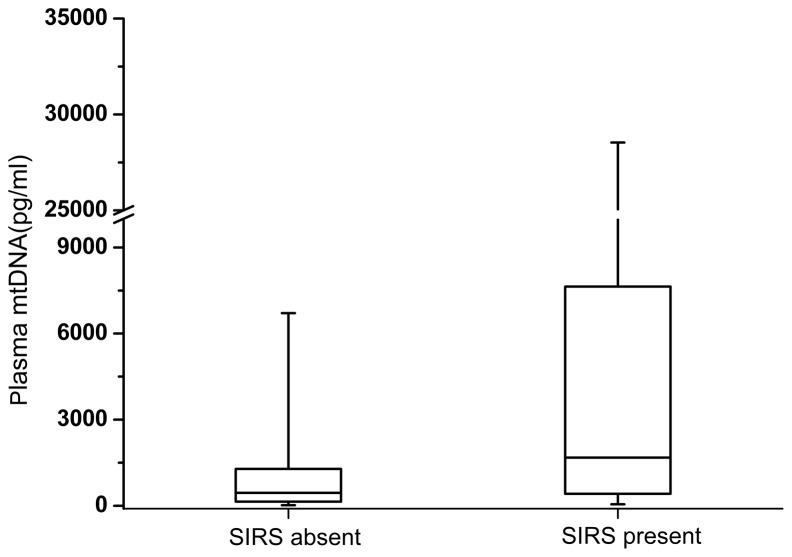
Box plots of the plasma mitochondrial DNA concentration in patients stratified by post-traumatic systemic inflammatory response syndrome present or absent.Plasma mtDNA concentrations presented as median values (line across the boxes), IQR (limits of the boxes), and 5th to 95th percentiles (whiskers). The plasma mtDNA concentration in patients who developed post-traumatic SIRS was significantly higher than for those who did not (P<0.001).